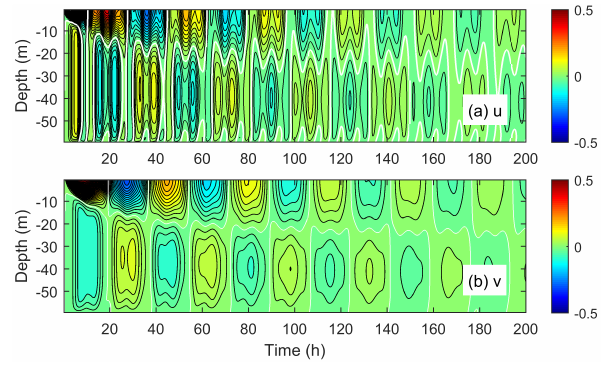
Figure 1. Velocities ( u and v , ms − 1 ) at x = 70km. The white lines denote the value of zero. The contour interval is 0.02ms − 1 for both panels.